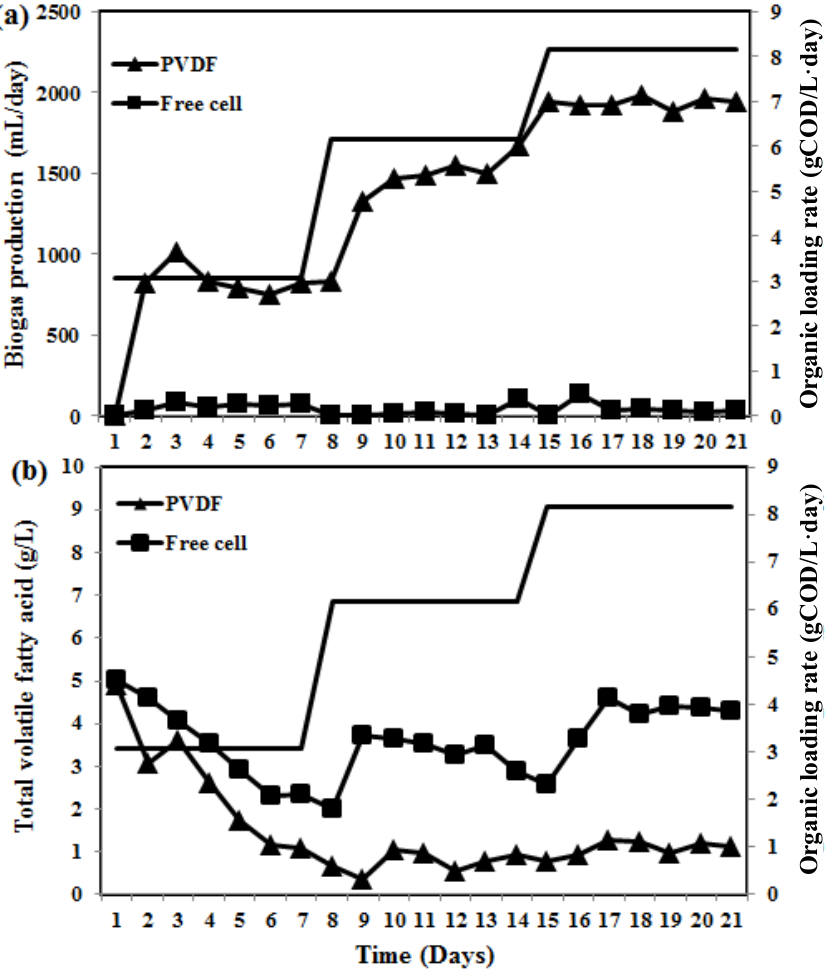
Figure 2. Performance of compact multi-layer membrane bioreactor (MMBR) compared to conventional system: ( a ) Daily biogas volumes produced; ( b ) Total volatile fatty acids in the bioreactor. The ramped solid lines indicate the organic loading rate and the symbols show the biogas production and total volatile fatty acids in ( a ) and ( b )